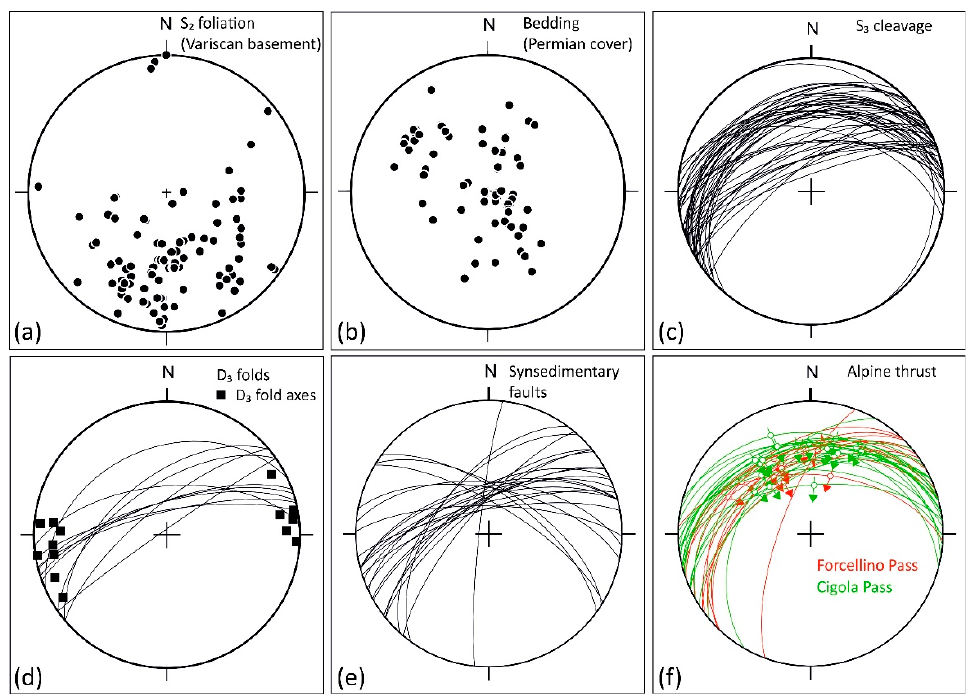
Figure 6. Field images of the main studied outcrop. ( a ) A tourmalinite vein propagated into the footwall paragneisses. ( b ) Reddish cataclasites after Mt. Aga Conglomerate with whitish quartz clast. They pass downward to gray cataclasites and black tourmalinites in contact with the footwall basement cataclasites. ( c ) Irregular contact between gray cataclasites/tourmalinites with the hosting reddish cataclasites, coin diameter is 22 mm. ( d ) Banded texture of tourmalinites with black levels made nearly entirely of tourmaline interleaved with gray-colored, partially tourmalinized cata- clasites. ( e ) Alpine S 3 cleavage (top-right to down left) developed within the LANF fault core, coin diameter is 22 mm. ( f ) Undulated contact between tourmalinites and the host rock, coin diameter is 22 mm.